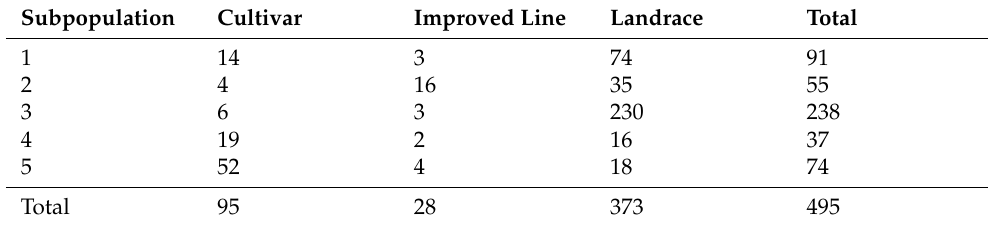
Figure 3. MDS plot by population type for 495 barley samples with 14,015 SNP markers in plink1.9 software.